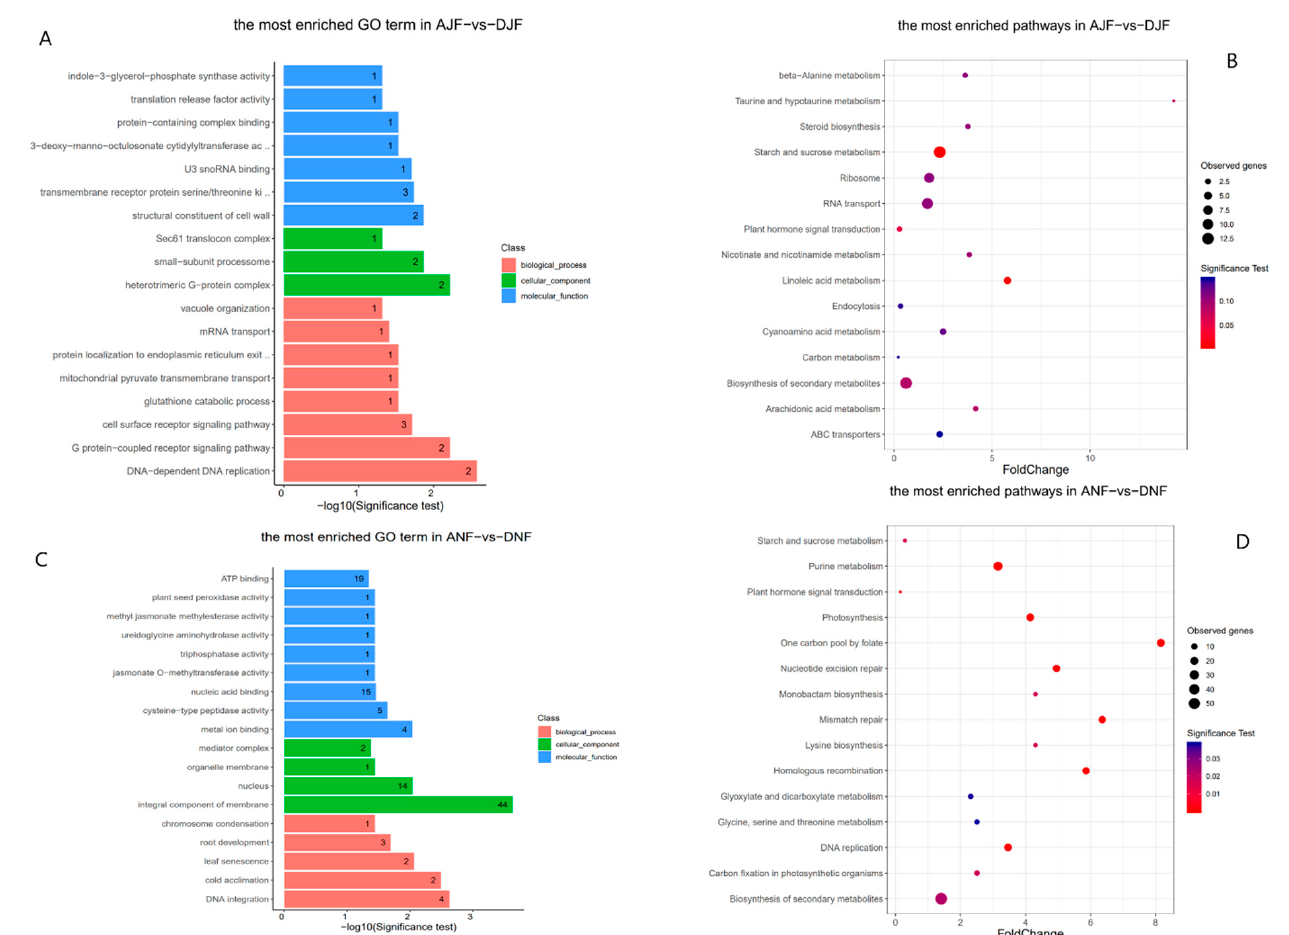
Figure 1. Enrichment analysis of methylated regions in cultivated and wild olives. ( A ) Most enriched gene ontology terms in methylated regions in both cultivated and wild fruits in July. ( B ) Most enriched KEGG pathways in methylated region in both cultivated and wild fruits in July. ( C ) Most enriched gene ontology terms in methylated region in both cultivated and wild November fruits. ( D ) Most enriched KEGG pathways of methylated regions in both cultivated and wild November fruits. ANF: Ayvalik November fruit, DNF: wild November fruit. AJF: Ayvalik July fruit, DJF: wild July fruit, where Delice is the Turkish name of the wild oleaster.